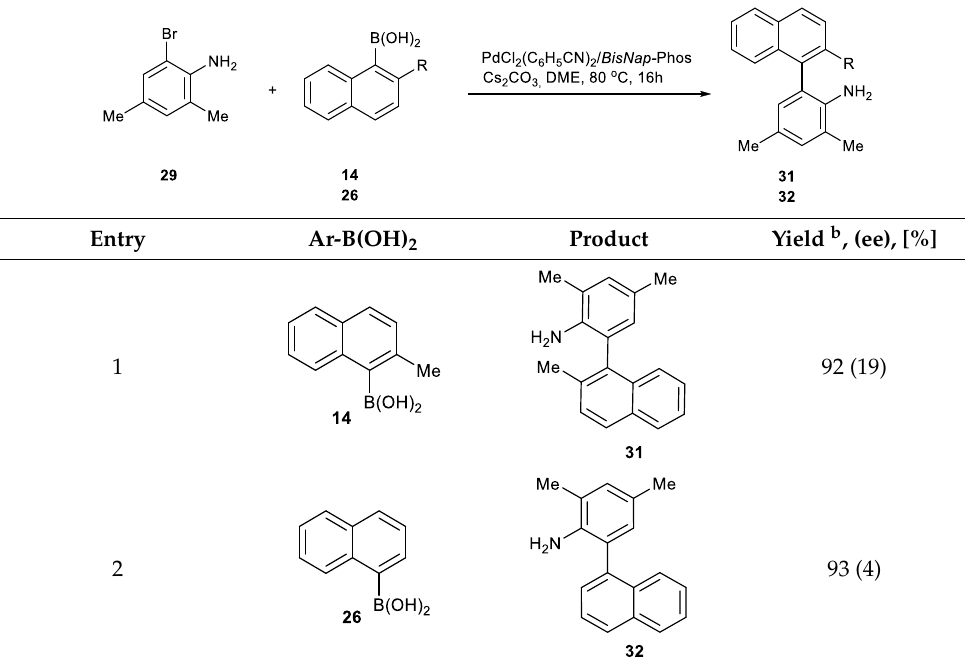
Table 16. Ligand activity in asymmetric synthesis of 34 a .